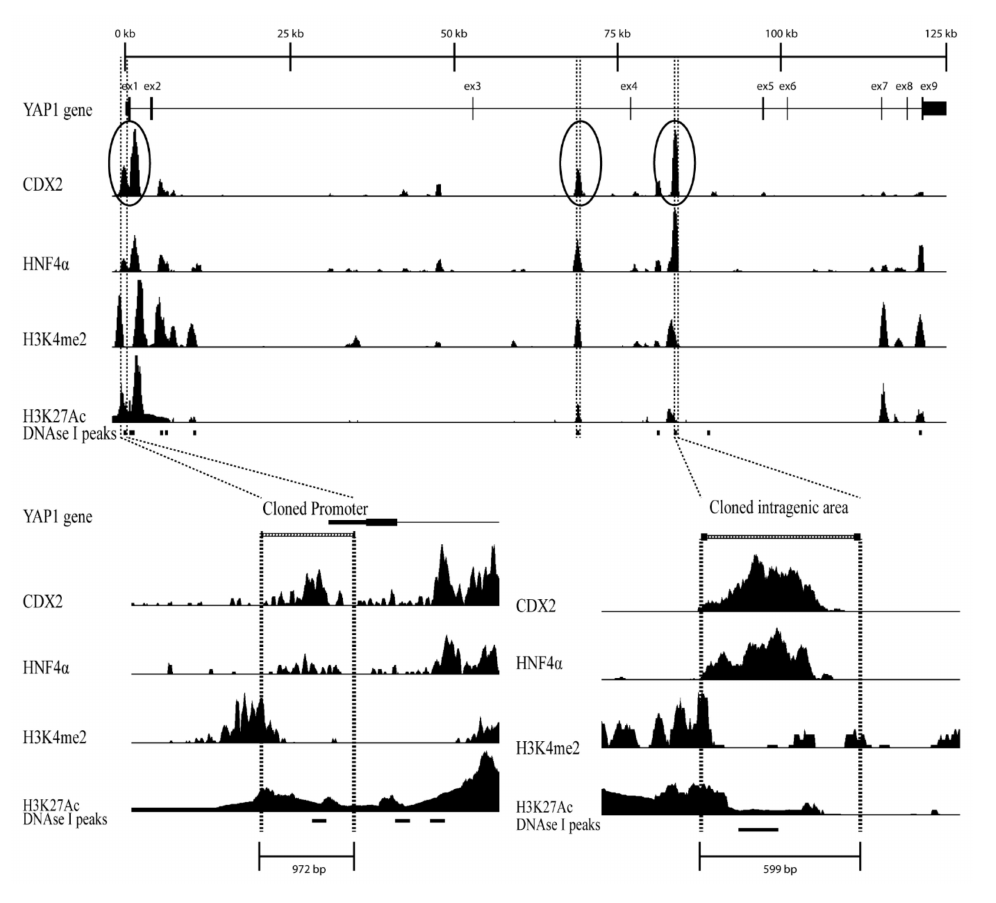
Figure 1. Putative regulatory regions within the YAP1 gene; ( Top ) View of the YAP1 gene region in the February 2009 GRCh37 / hg19 genome assembly at http: // genome.ucsc.edu. ChIP-seq data for CDX2, HNF4 α , H3K4me2, and H3K27Ac, from confluent Caco-2 cells is shown as density graphs [39]. Circles and dashed lines indicate the promoter and intragenic regulatory regions in the YAP1 gene; ( Bottom Left ) View of the promoter region of the YAP1 gene spanning 972 bp ( − 0.7 kb to + 0.3 kb relative to the transcription start site (TSS)); ( Bottom right ) View of the intragenic regulatory region in intron 4 of the YAP1 gene spanning 599 bp ( + 82.2 kb to + 82.8 kb relative to the TSS). The black bars in the DNase I track [42] from Caco-2 cells represent a significant increase in DNase sensitivity in these